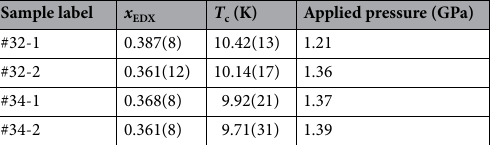
Table 1. Sample label, x EDX , and T c for the isotope samples of Sr 1− x La x FBiS 2 .